Question: Which kind of chart has been used to present this data?
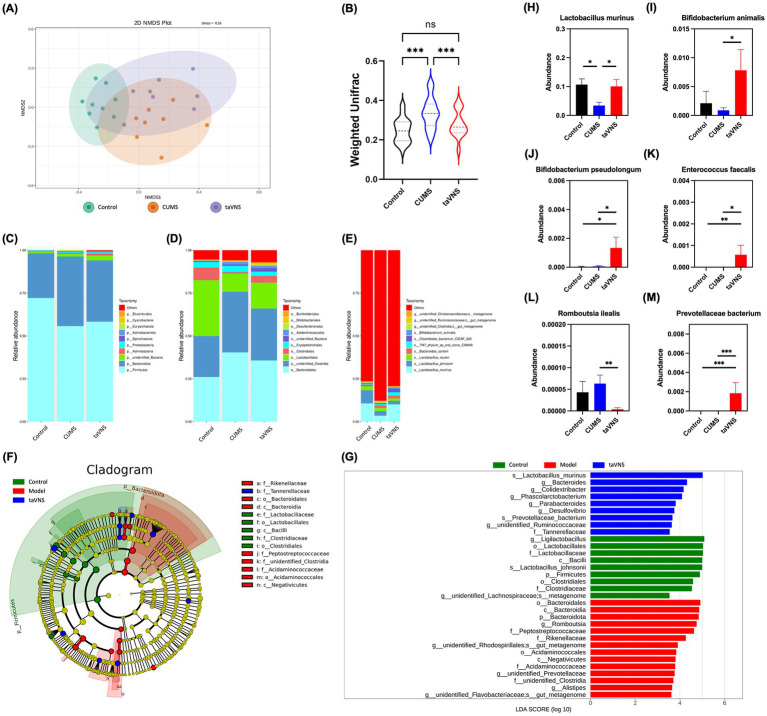
Answer: histogram